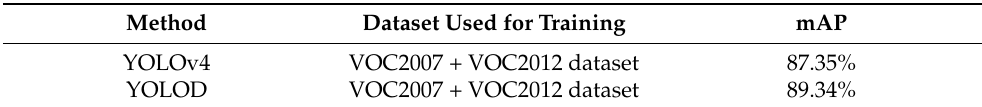
Table 6. Results of training on the VOC2007 + VOC2012 dataset.